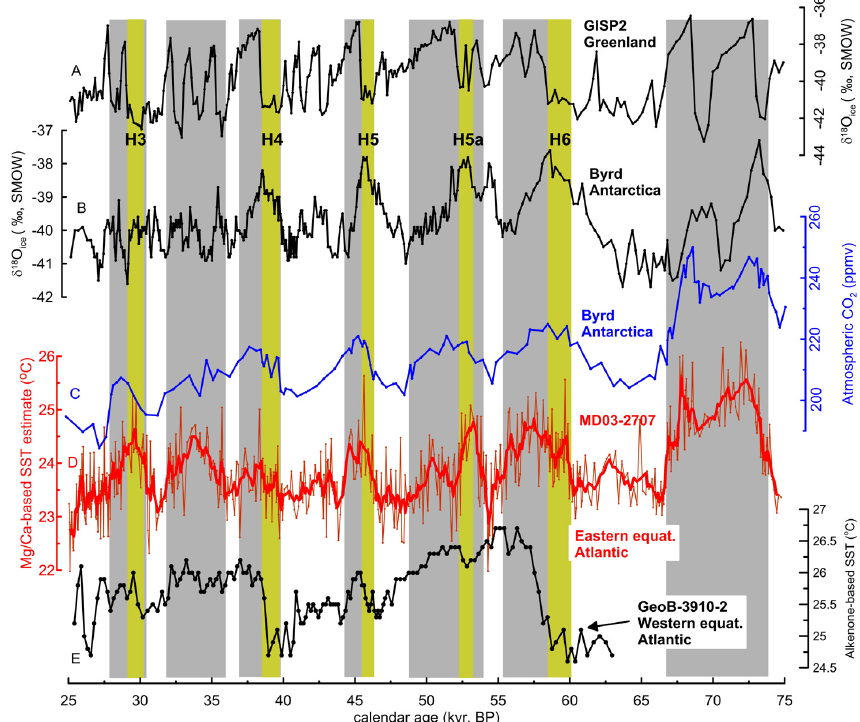
Fig. 5. (a) Greenland and (b) Antarctica ice core δ 18 O records (Blunier and Brook, 2001) compared with (c) atmospheric CO 2 (Ahn and Brook, 2008) and (d) eastern equatorial Atlantic SST estimates (red bold line: 5-point running average). (e) Shown are also alkenone-based SST estimates from western equatorial Atlantic (Jaeschke et al., 2007). Gray and yellow (period of Heinrich events) bars indicate EEA warm